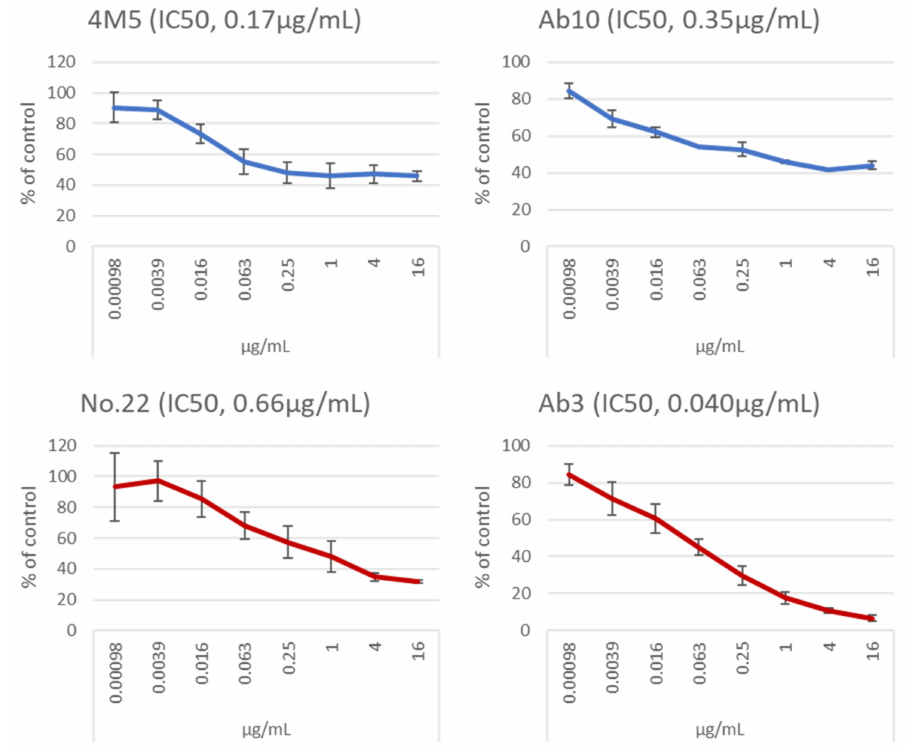
Figure 1. Inhibitory effects of two anti-Gn mAbs (4M5 and Ab10) and two anti-Gc mAbs (No. 22 and Ab3) against replication-defective vesicular stomatitis virus vector carrying SFTS virus Gn/Gc as envelope proteins. The x -axis indicates concentration of the mAb used to treat virus and the y -axis indicates reporter-positive cell number percentages against control (mAb 0 µ g/mL). Experiments were performed at triplicates. Data are the means ± standard